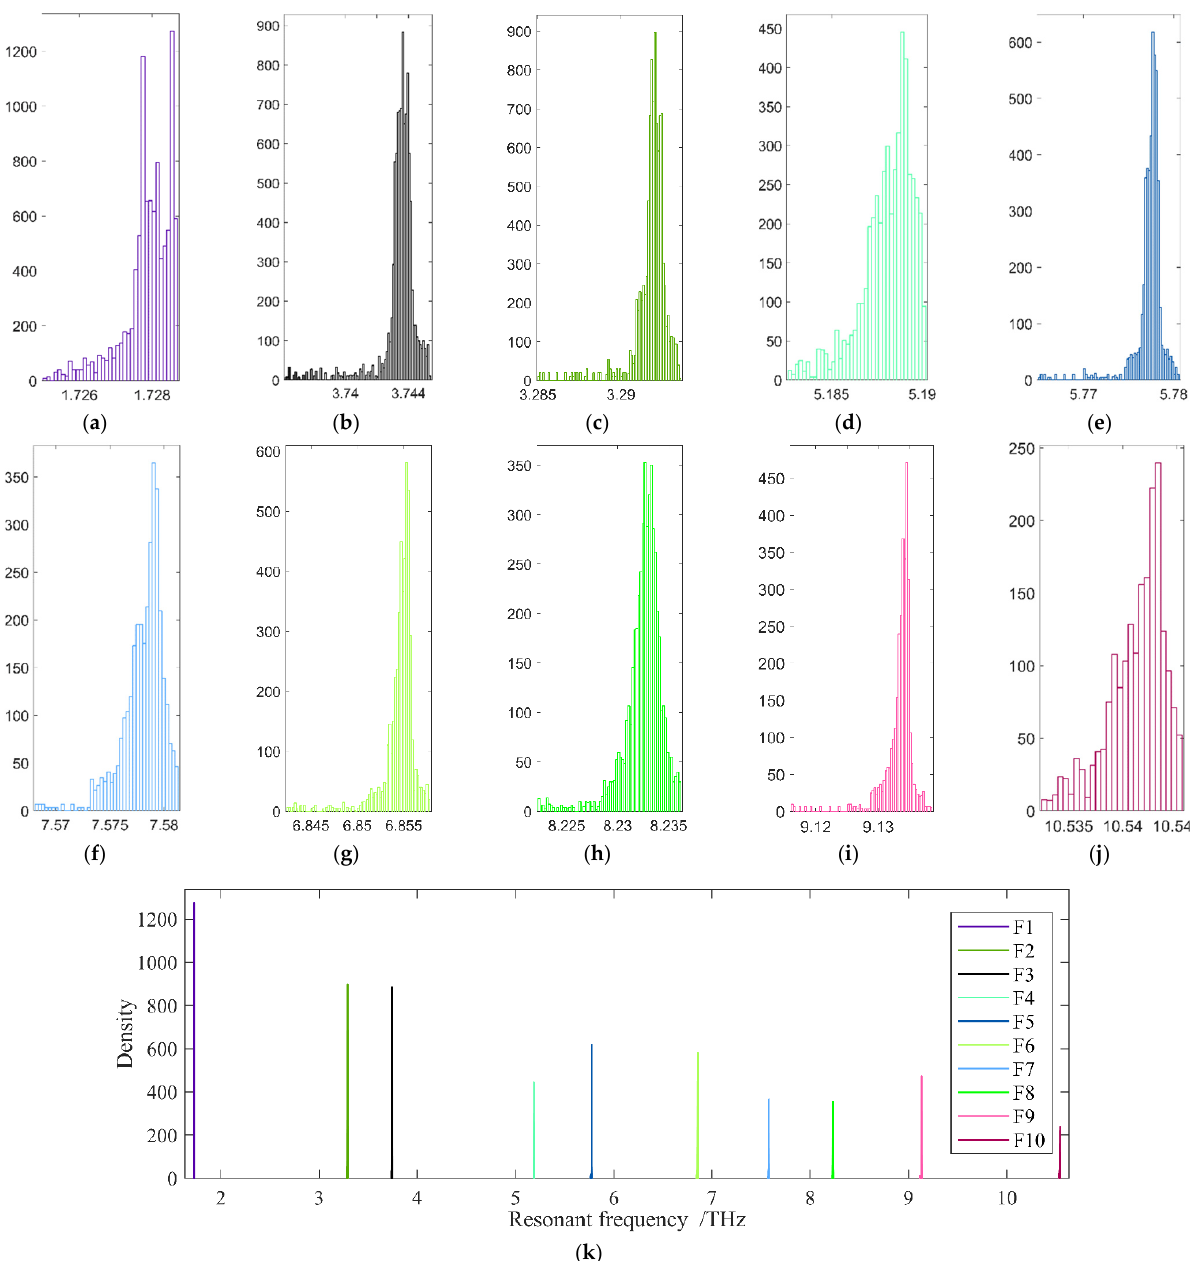
Figure 3. The probability density distribution of resonant frequencies ( a – j ) represent the first ten resonant vibration modes, respectively; ( k ) is the comparison of density in the same magnitude, and the colors in ( k ) correspond to those in ( a – j ), respectively.